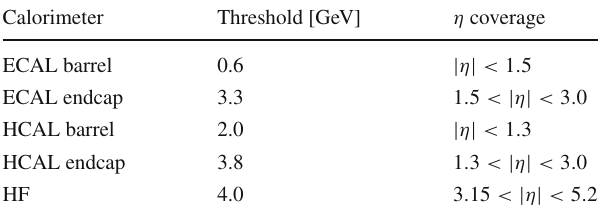
Table 1 The value of calorimeter thresholds for different calorimeter constituents, used in the selection of exclusive